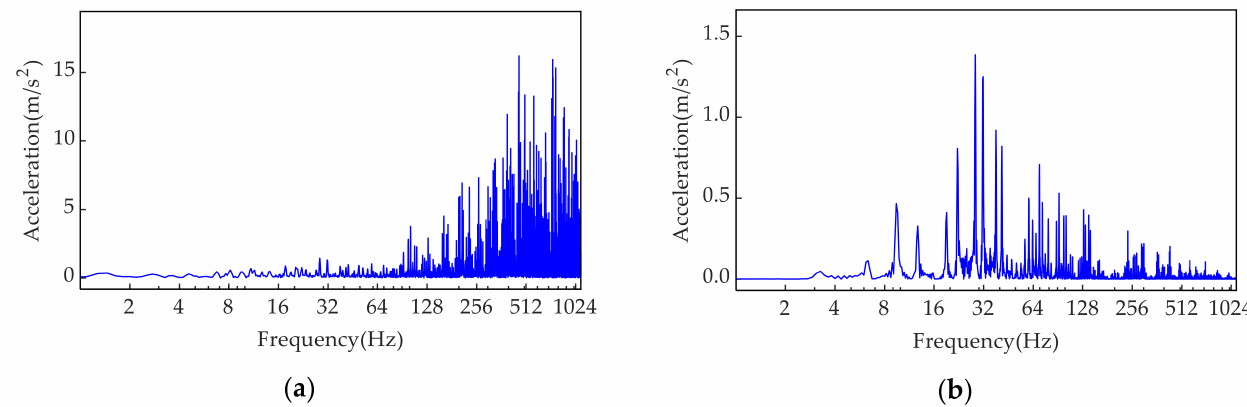
Figure 17. Frequency distribution of the vertical acceleration of the rail under: ( a ) track short wave irregularity; ( b ) track medium-long wave irregularity.